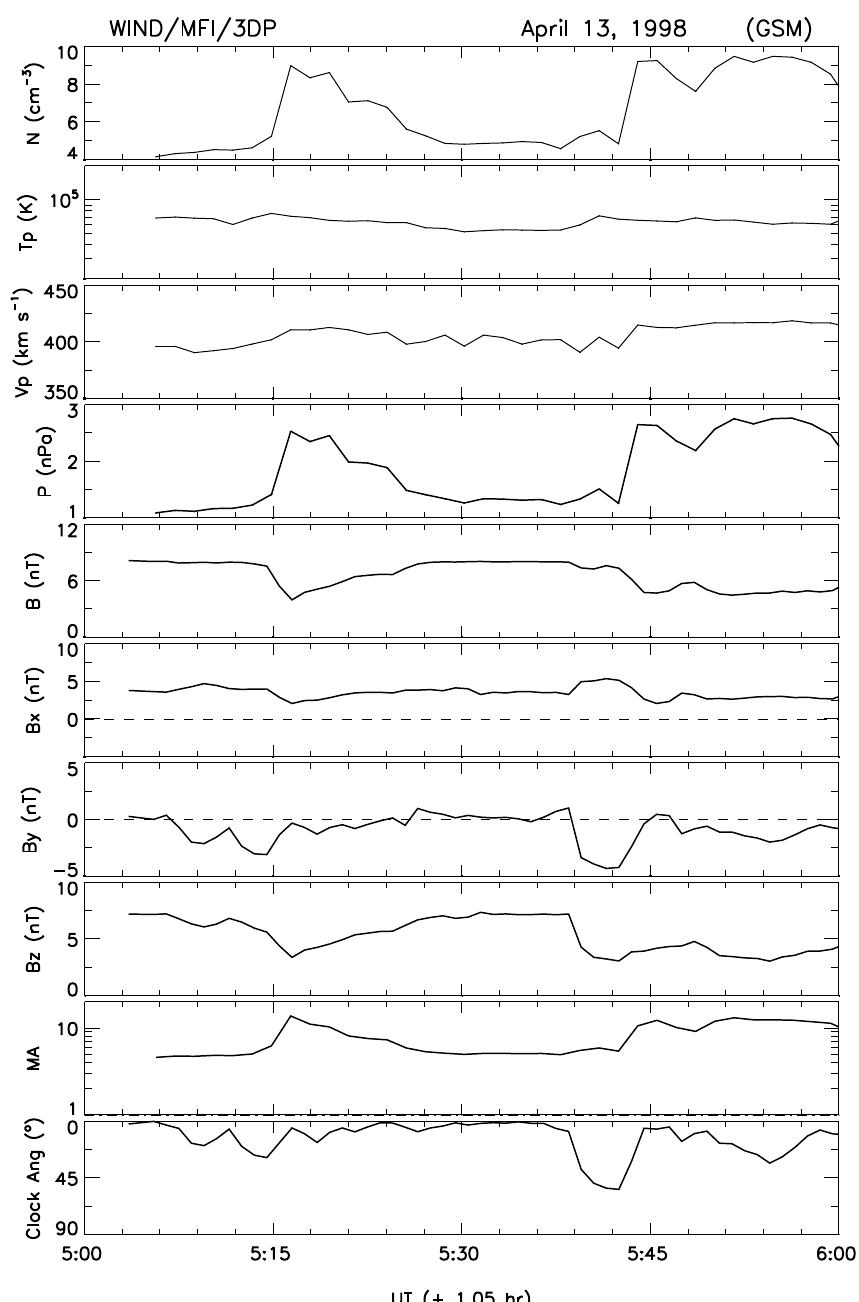
Fig. 3. Interplanetary data from Wind for the event on 13 April 1998: proton density, temperature, bulk speed, dynamic pressure, GSM components of the magnetic field, total field strength, Alfvén Mach number, and IMF clock